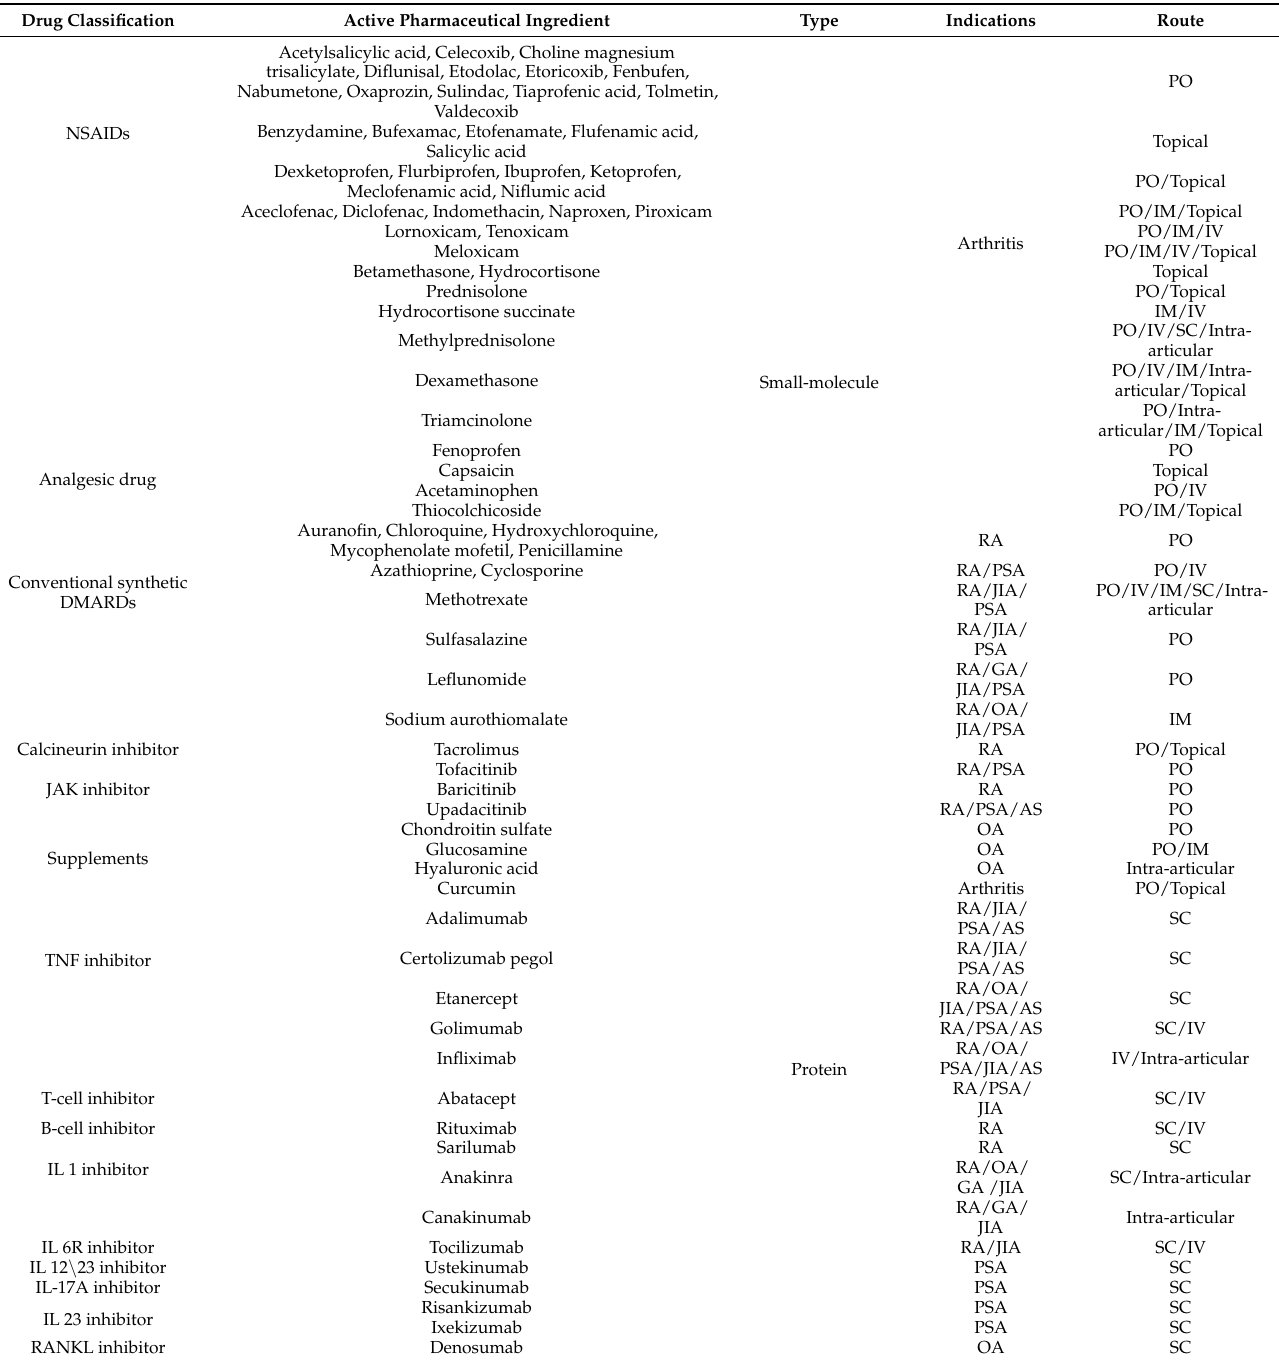
Table 2. Summary of drugs for arthritis